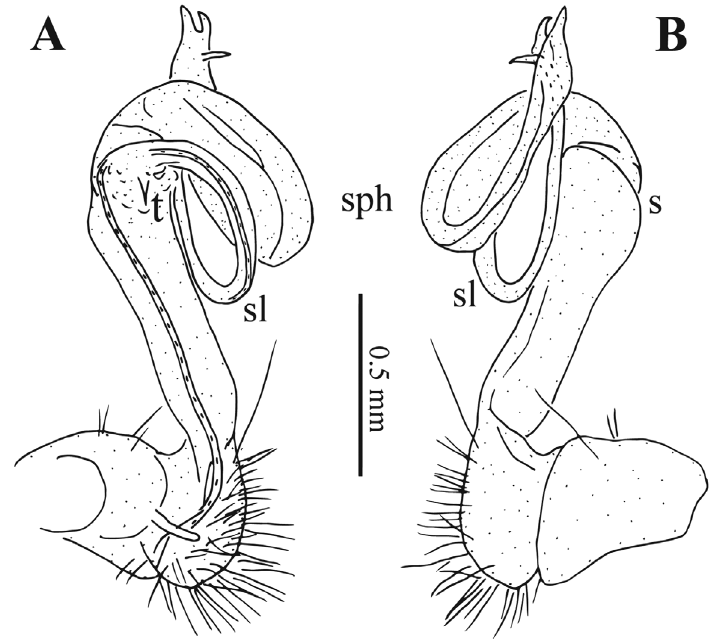
Figure 8. Tonkinosoma tiani sp. n., ♂ paratype from Ganhan Cave. A, B left gonopod, submesal and lateral views, respectively. Abbreviations: s = sulcus; sl = solenomere; sph = solenophore; t =